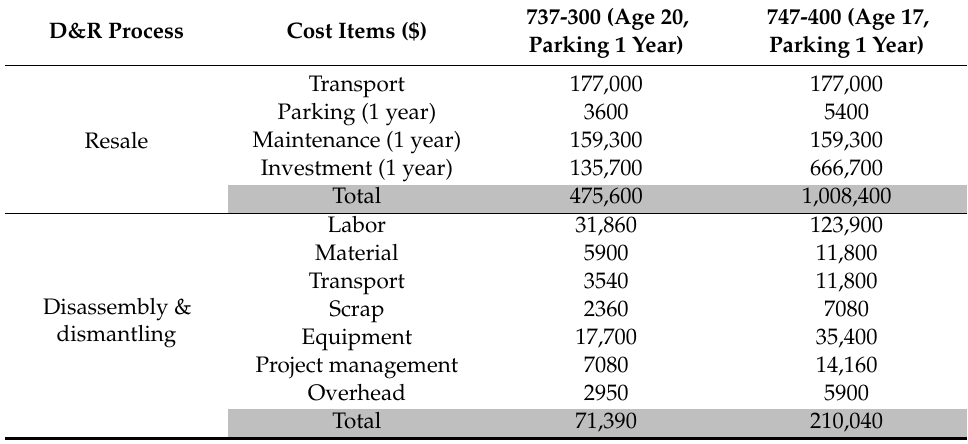
Table 8. Disposal and recycle costs for 737-300 and 747-400 disposal and recycle cases (2005 USD).